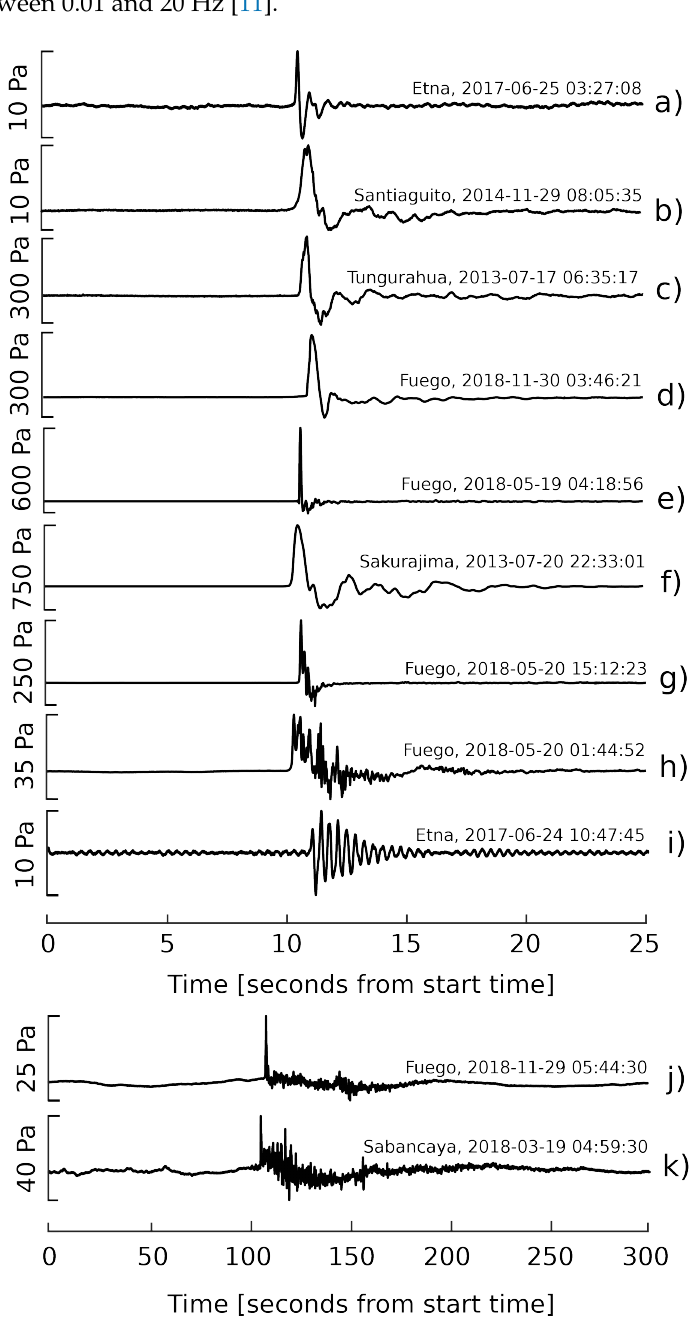
Figure 1. Infrasound waveforms associated with explosions at volcanoes that exhibit regular activity. Excess pressures are reduced to a distance of 1 km from the vent for comparison across volcanoes: ( a ) small degassing explosions recorded at Etna, Italy; ( b ) small degassing explosions recorded at Santiaguito, Guatemala; ( c , d ) ash-rich impulsive explosions from Tunghurahua, Ecuador, and Fuego, Guatemala; ( e , f ) large amplitude signals exhibiting blast wave characteristics recorded at Fuego, Guatemala, and Sakurajima, Japan; ( g , h ) short-duration signals featuring multiple pulses from Fuego, Guatemala; ( i ) monochromatic signal recorded at Mt. Etna associated with degassing activity from one of the summit vents; abd ( j , k ) explosion signals with impulsive onsets followed by an extended coda from Fuego, Guatemala, and Sabancaya, Peru, associated with observations of sustained ash